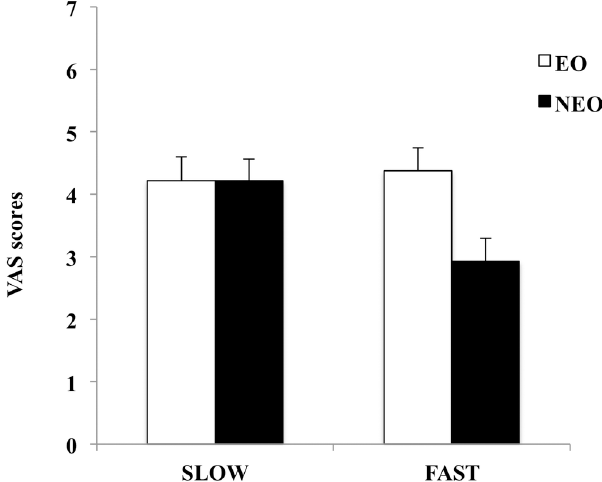
Fig 4. VAS scores (means ± SE) given by expert ([EO] white columns) and non-expert ([NEO] black columns) observers for performance at slow and fast pace. The values are the grand averageof scores for technicaland aesthetic qualitiesfor all swimmers (HLP, MLP, and LLP).